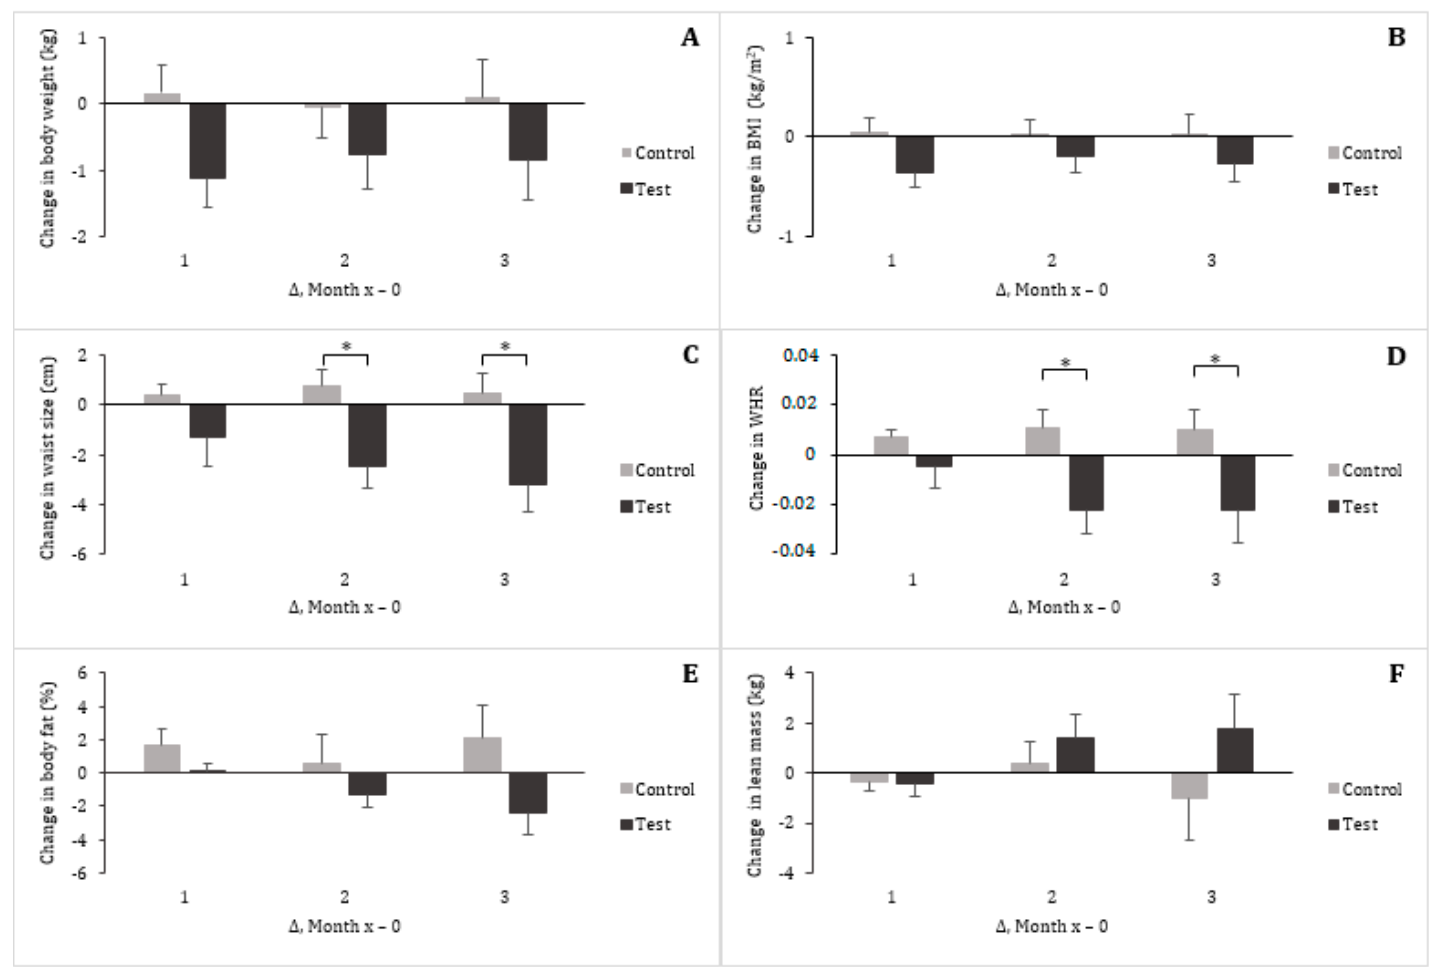
Figure 2. Changes ( ∆ ) in body weight ( A ), body mass index (BMI) ( B ), waist circumference ( C ), waist-to-hip ratio (WHR) ( D ), percentage of body fat ( E ) and lean body mass ( F ) in men and women daily consuming two eggs enriched in oleic acid (control group) or two eggs enriched in α -linolenic acid (ALA), docosahexaenoic acid (DHA), rumenic acid (RmA) and punicic acid (PunA) (test group), from the start of the study (Month 0) to months 1, 2 and 3 (Months x). Mean (± SEM). (*) for significant differences between control group and test group at p < 0.05, analyzed using t -test.